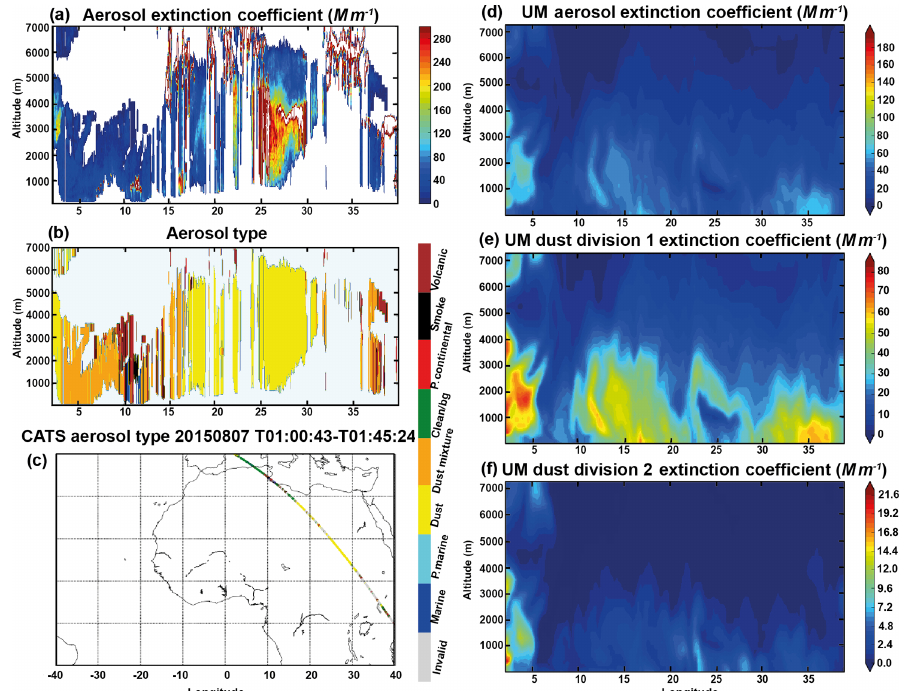
Figure 19. (a–c) CATS and (d–f) MetUM data for 00:00Z on 8 August in the form of vertical cross sections along the satellite track: (a) CATS aerosol extinction coefficient; (b) CATS feature type; (c) CATS overpass track; (d) MetUM total dust extinction coefficient; (e) MetUM d1 dust extinction coefficient; and (f) MetUM d2 dust extinction coefficient.